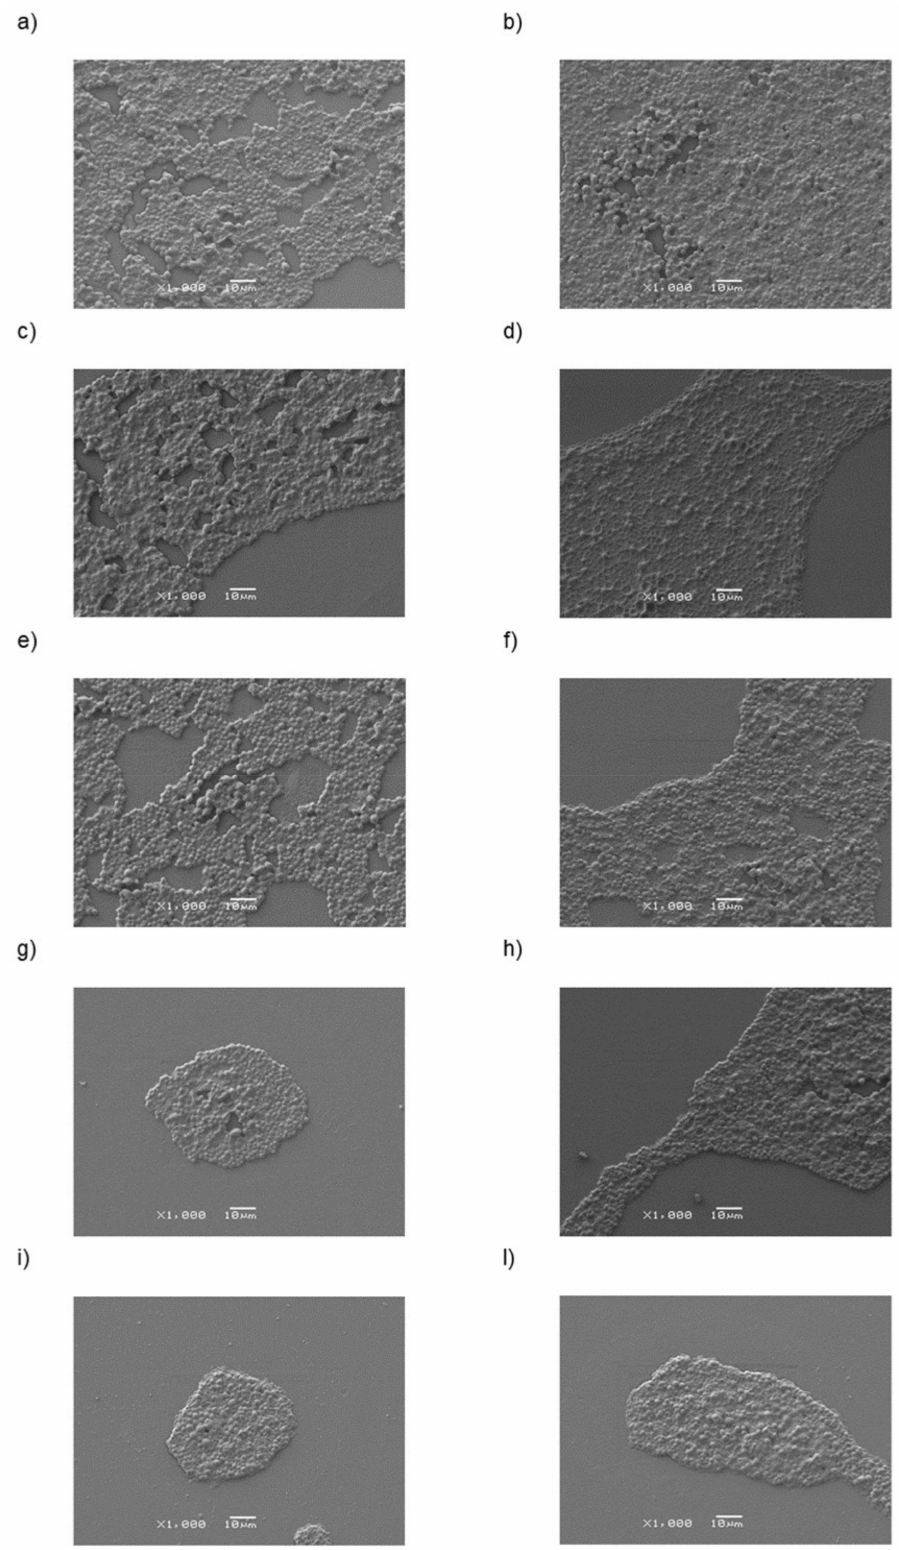
Figure 7. Representative SEM images at 1000 × magnifications of C. albicans presence on different PMMA-based substrates: PMMA ( a , b ), PMMA + TiO 2 NPs 1% ( c , d ), PMMA + TiO 2 NPs 3% ( e , f ), PMMA+ HNTs 1% ( g , h ), PMMA+ HNTs 3% ( i , l ) substrates at different time points 24 h ( a , c , e , g , i ) and 48 h ( b , d , f , h , l